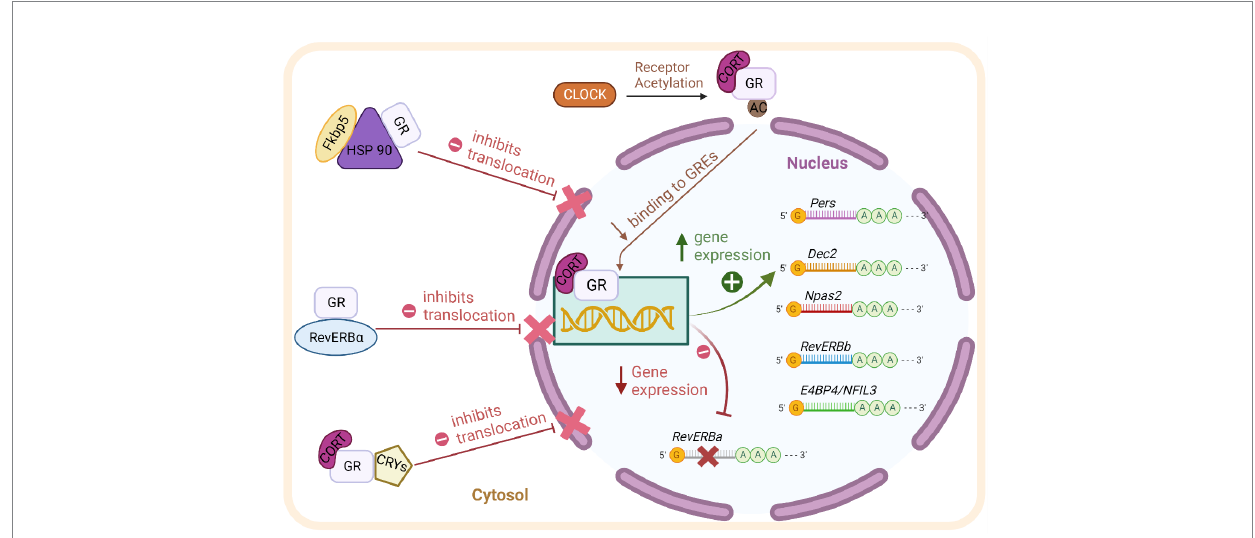
FIGURE 1 Scheme of the reciprocal molecular interaction between GR and the clock machinery at transcriptional, translational, and post-translational levels as described in detail in the text. BMAL1: brain and muscle aryl hydrocarbon receptor nuclear translocator-like 1. CLOCK: circadian locomotor output cycles kaput. Pers: Periods. Dec2: differentially expressed in Chondrocytes 2. Npas2: Neuronal PAS Domain-Containing Protein 2. RevErb-beta: Nuclear Receptor Subfamily 1 Group D Member 2. AC: acetyl group. GR: Glucocorticoid receptor. RevERb-Alpha: Nuclear Receptor Subfamily 1 Group D Member 1. CRY1/2 (Cryptochrome 1/2). HSP90: Heat shock protein 90. FKBP5: FK506-binding protein 5. CORT: